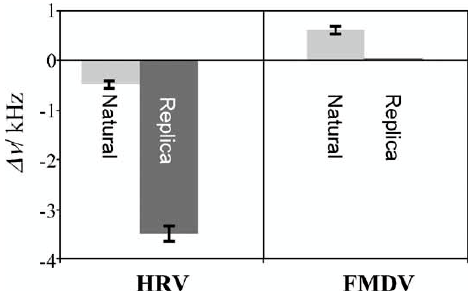
Figure 8. Comparison of sensor responses of natural antibodies and plastic replica of antibodies prepared by imprinting against HRV and FMDV, the replica antibodies were imprinted with HRV, reproduced with permission from [121].